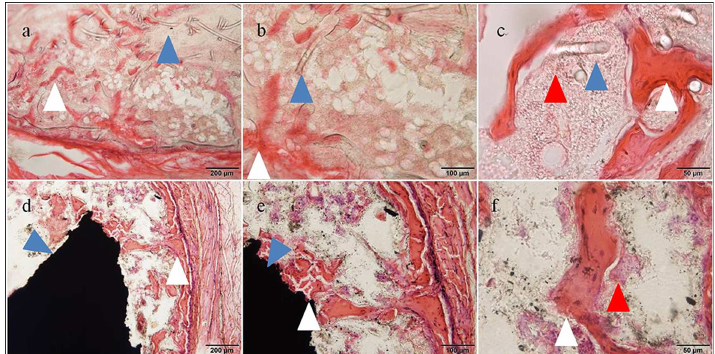
Fig 7. Histological images taken 3 weeks after implantation in mouse back muscle (Hematoxylin- eosin staining). (a, b, c) Ectopic bone formed by an rhBMP-2-containingPET-fiber-reinforcedcollagen sheet. Blue arrow: remnant of PET-fiber-reinforcedcollagensheet. White arrow: Trabecular structure of newly formed bone. Red arrowhead:Bone marrow cells. (d, e, f) Ectopic bone formed by an rhBMP-2-containing MWCNT block. The newly formed bone was found to contain a small number of MWCNTs. Blue arrowhead: MWCNT block. White arrowhead:trabecular structure of newly formed bone. Red arrowhead: Bone marrow cells.